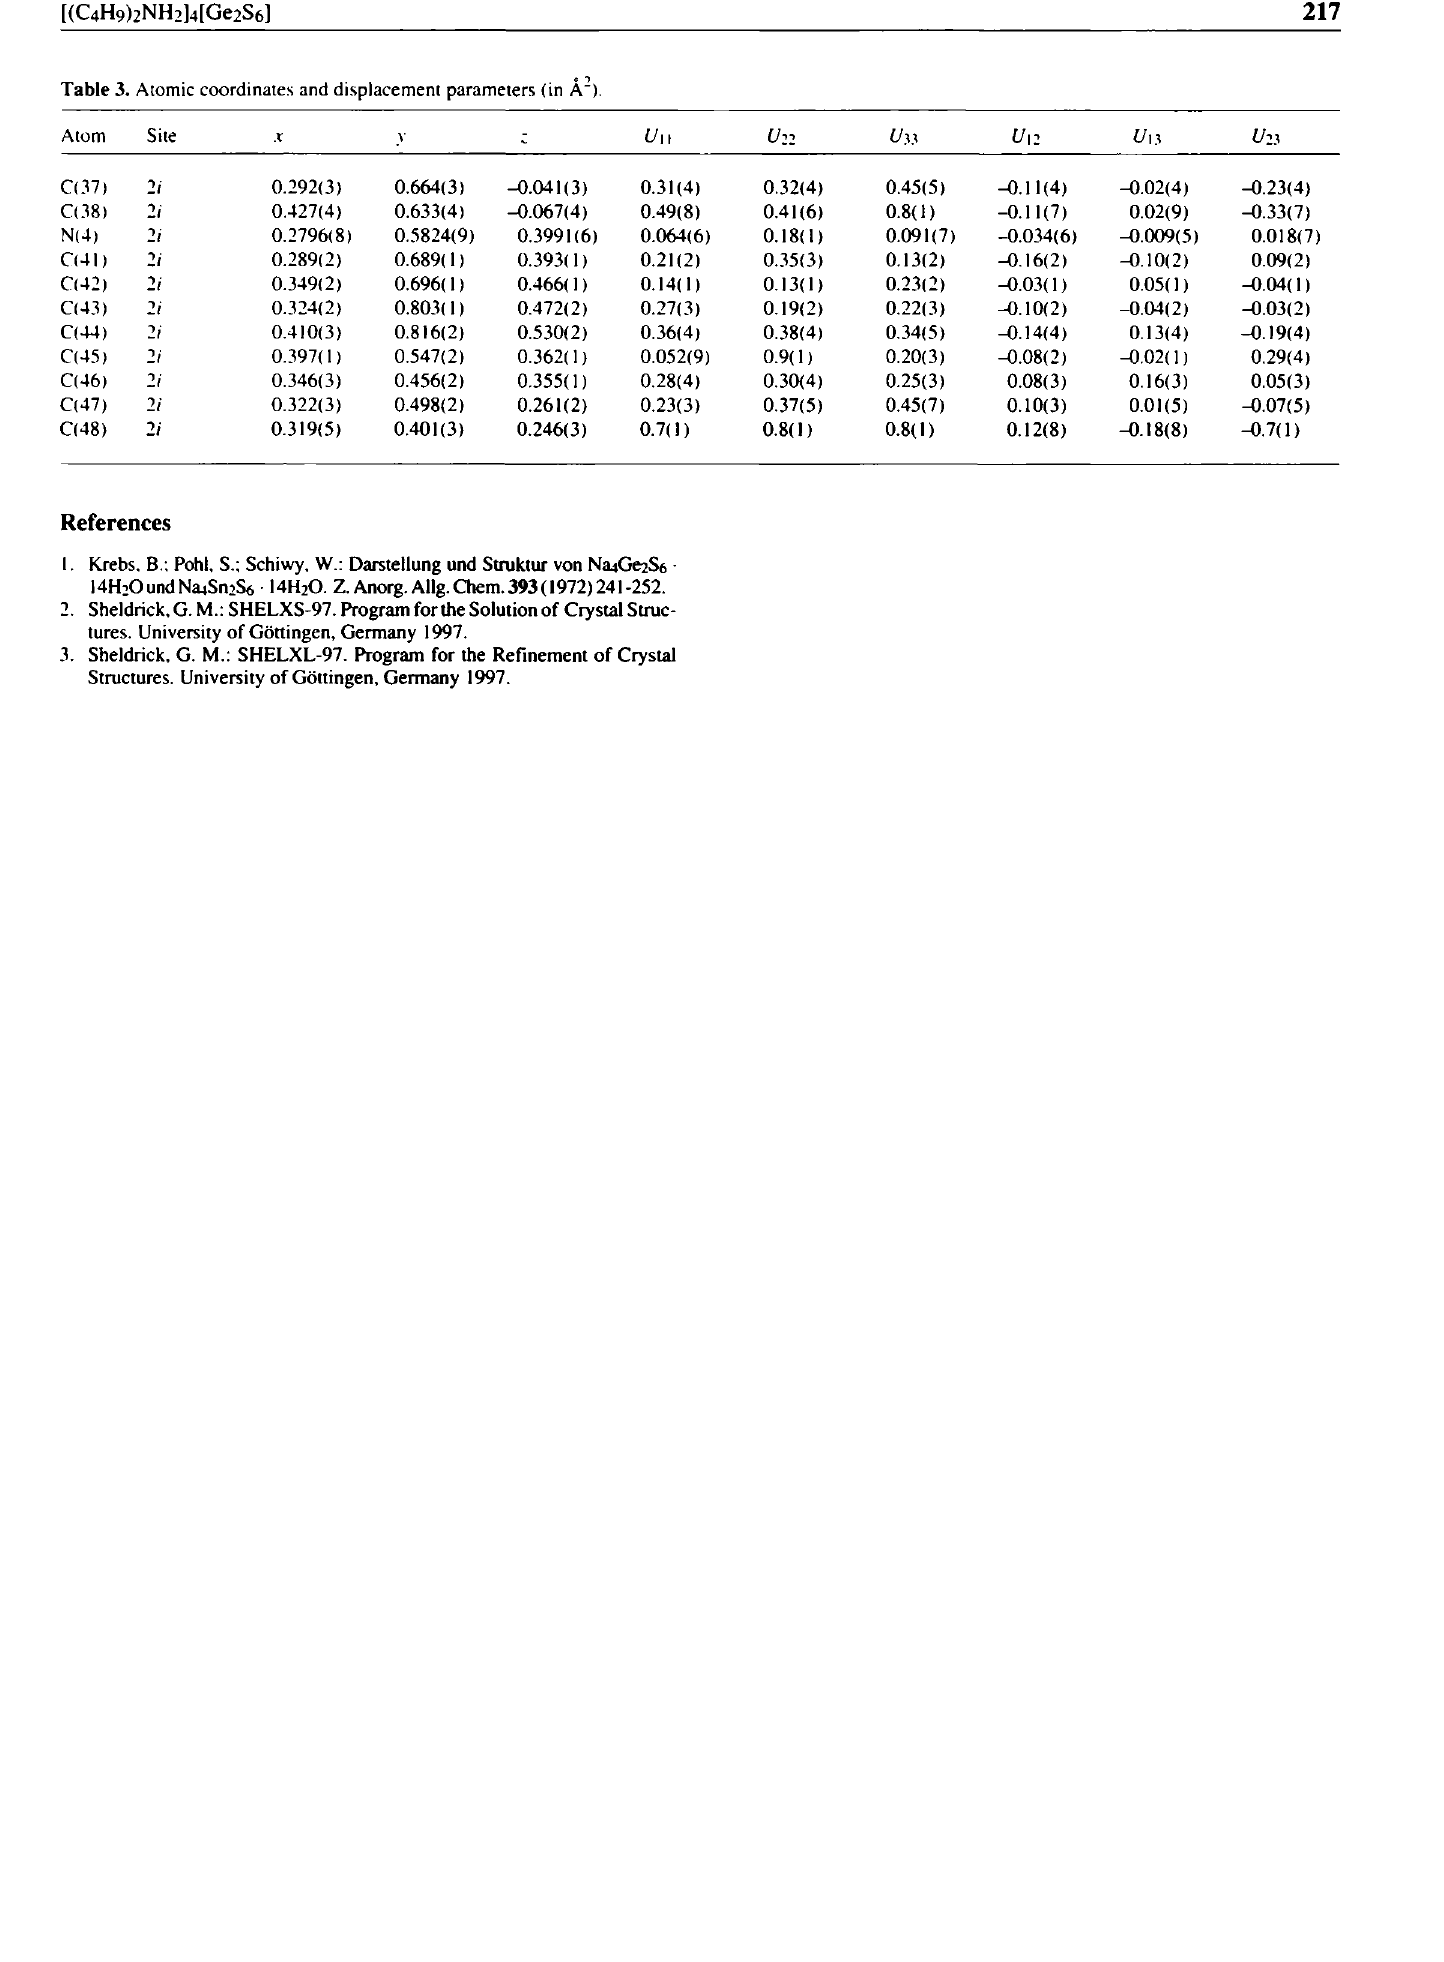
Table 3. Atomic coordinates and displacement parameters (in A 2